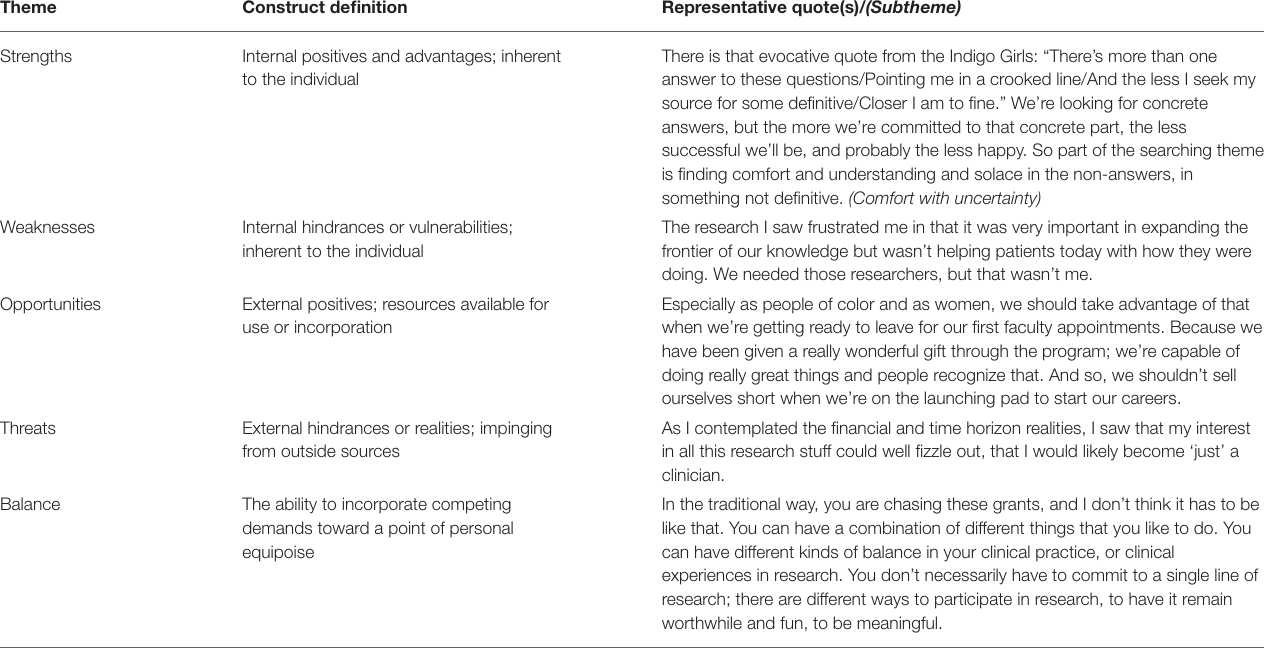
TABLE 2 | Individual characteristics: SWOT-B